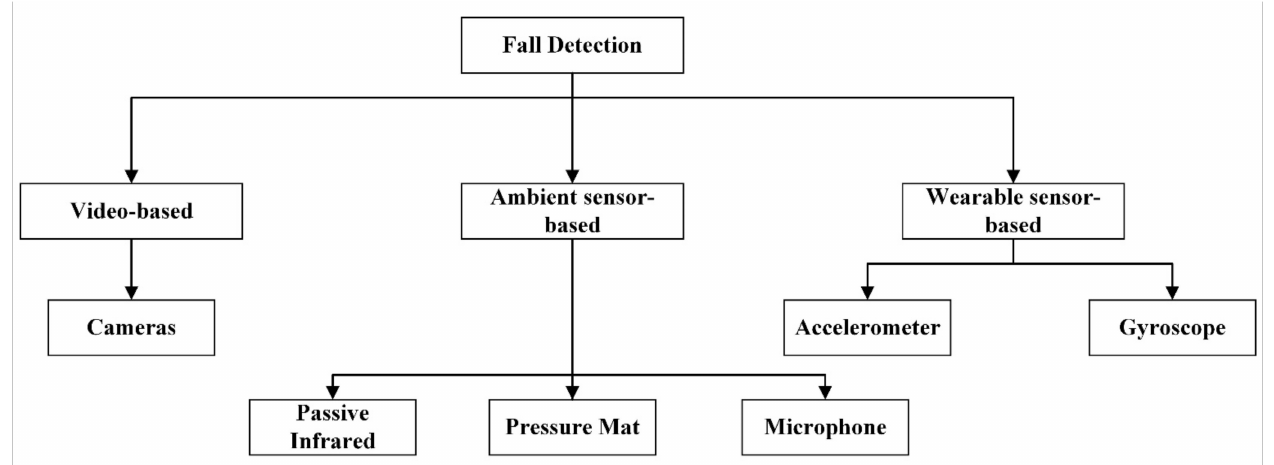
Figure 1. Classification of fall detection system